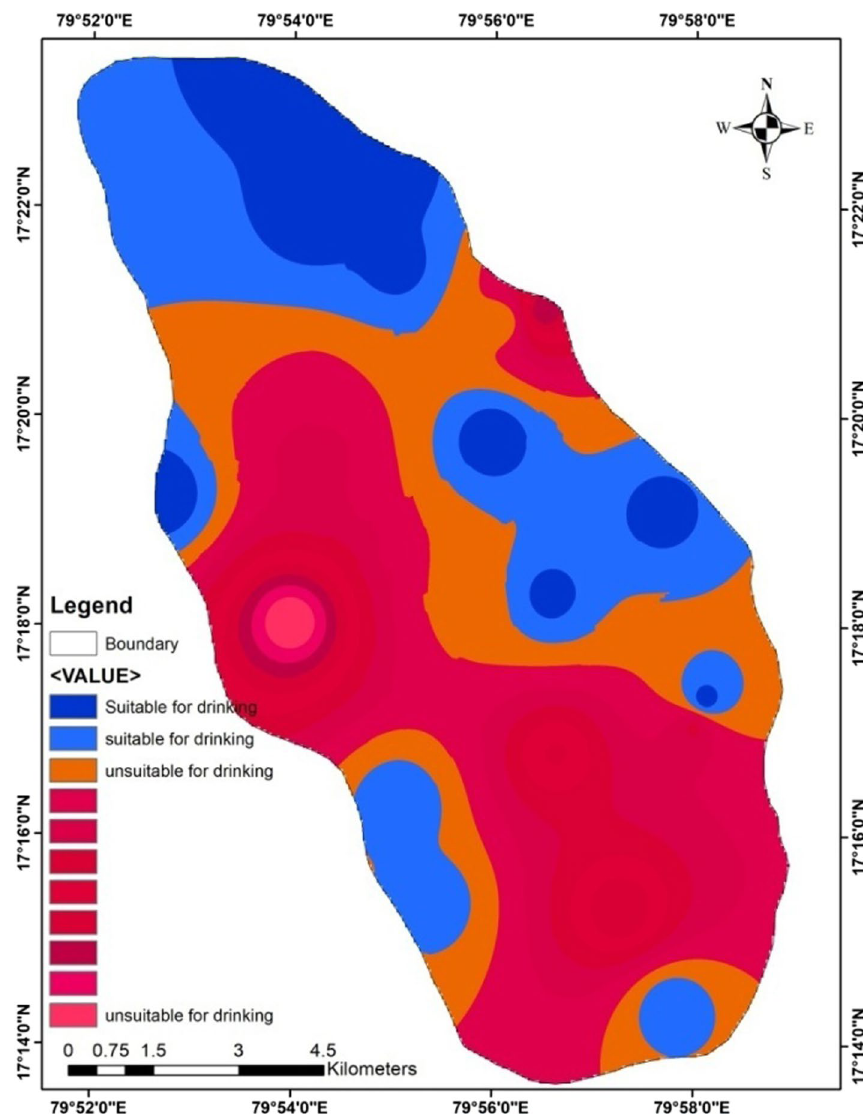
Fig. 9 Integrated groundwater quality map of the Subledu Basin for drinking purposes